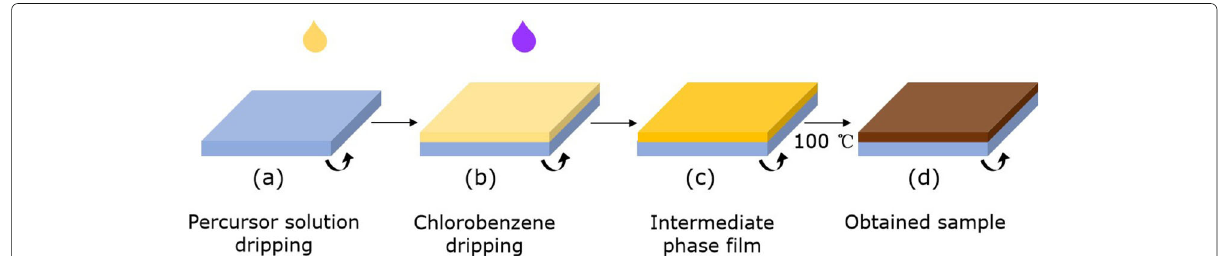
Fig. 1 Solvent engineering procedure for preparing the KCl-doped MAPIC film on the ITO-coated glass